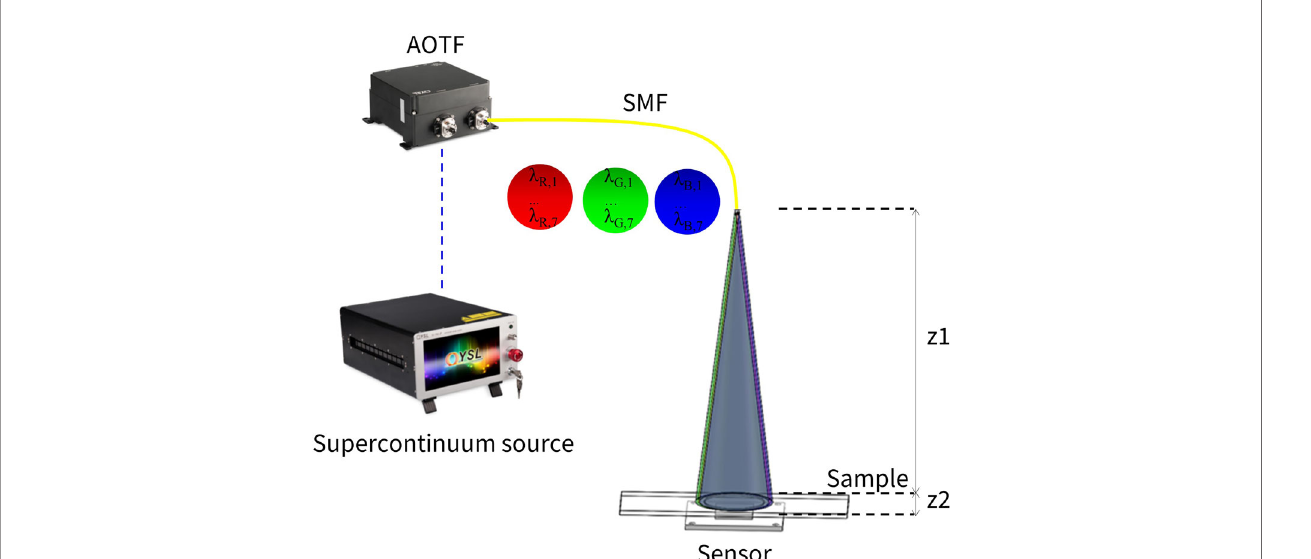
FIGURE 1 | Schematic diagram of a wide- fi eld pixel super-resolution colour lensfree microscope. The supercontinuum source outputs a continuum beam with a wavelength range of 410 – 2,100 nm. After being tuned by an acousto-optic tunable fi lter (AOTF), it is coupled into a single-mode fi bre (SMF), and the SMF outputs wavelength scanning sequence of the three bands – R, G and B. The emitted light directly illuminates the sample without being collimated, and the image sensor records the light intensity